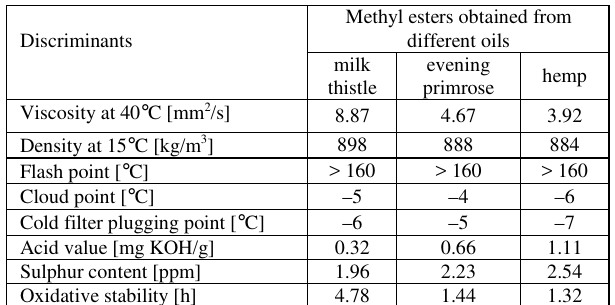
Table 2. Characteristics of the prepared methyl esters Discriminants